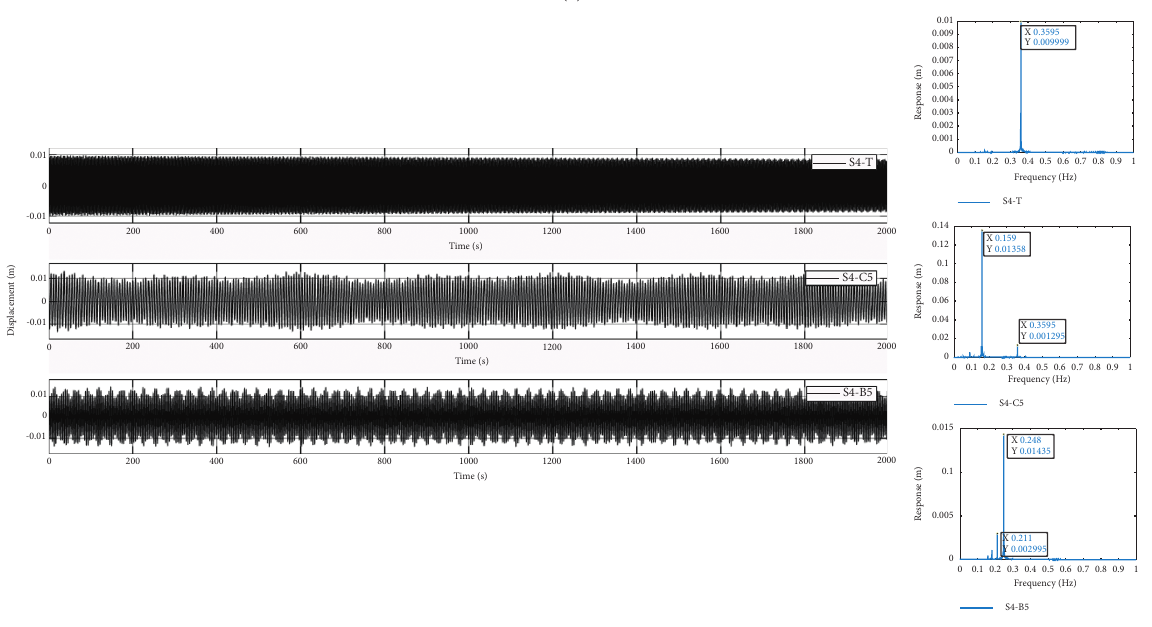
1 condition, the spectrograms of the tower,